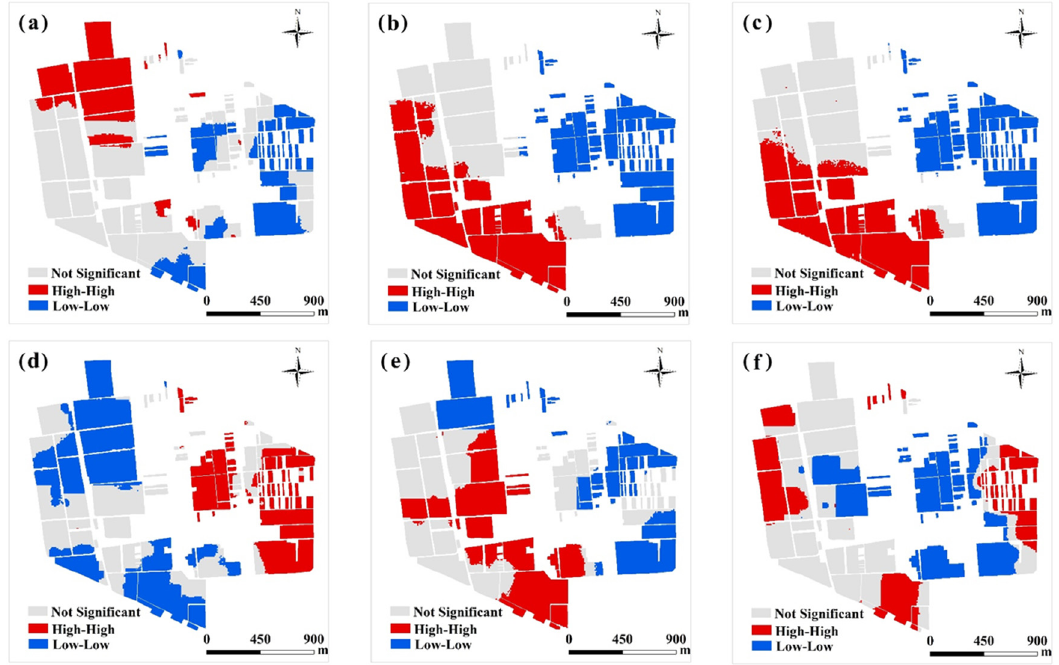
Figure 2. Spatial pattern maps for six different variables by visualizing the local indicators of spatial association (LISA). ( a ): pH; ( b ):TN; ( c ):OM; ( d ): AP; ( e ): AK; ( f ): ECa. Not significant: the statistic is not significant at 0.05 level, which were not referenced; High–High: high values in a high value neighborhood; Low–Low: low values in a low value neighborhood.